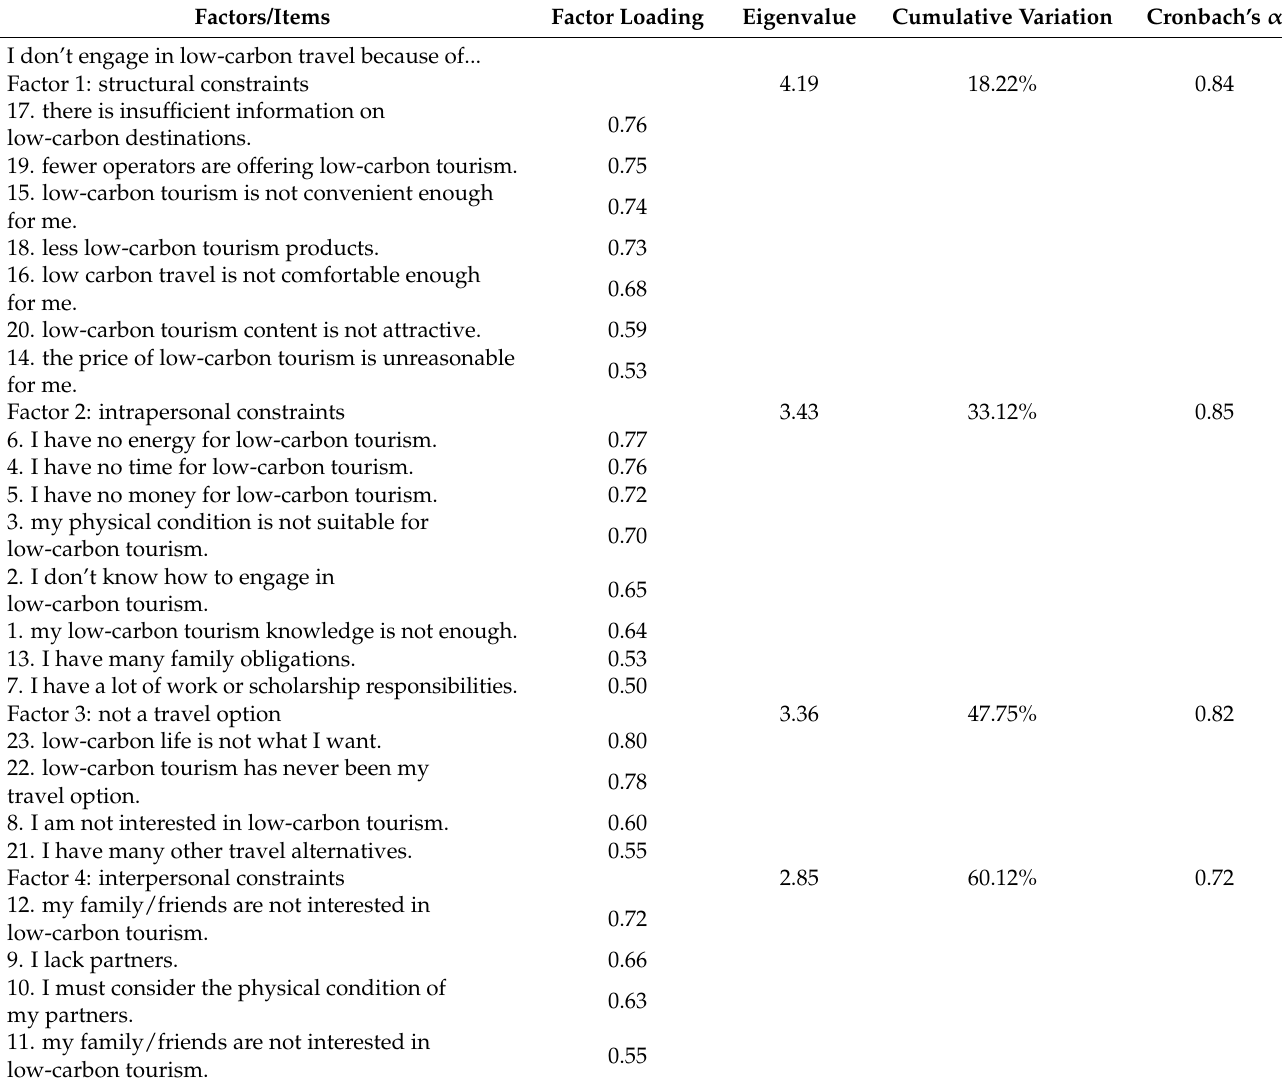
Table 3. EFA results of LCTCS—sample from low-carbon destination ( n =